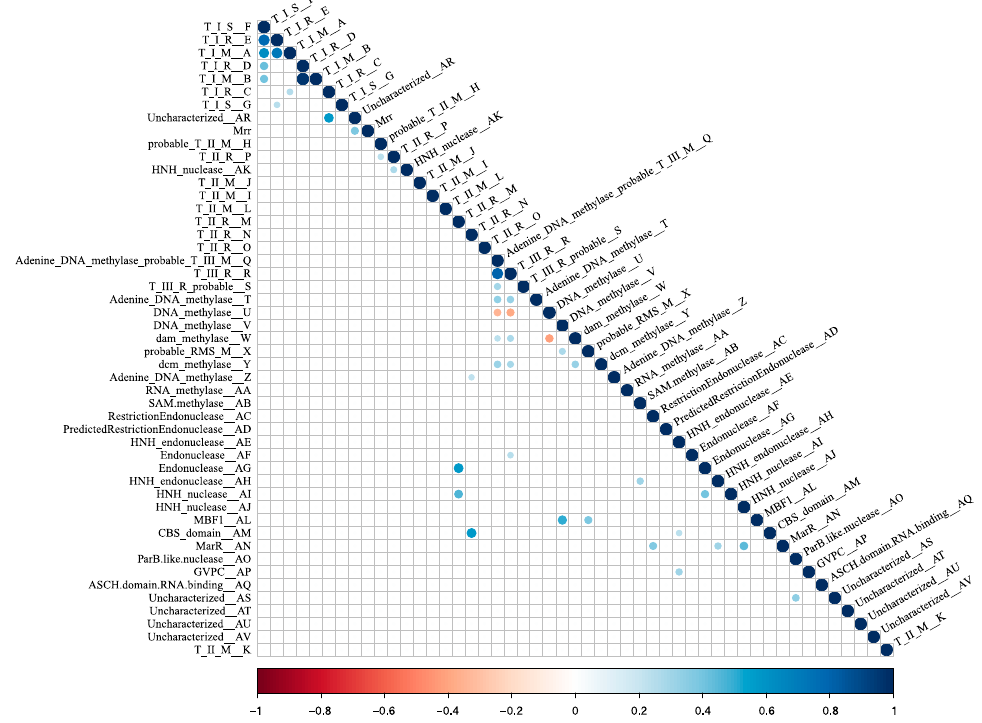
Figure 4. Heatmap of co-occurrence between the 48 RMS-candidate cHGs. Positive correlation indicates the cHGs co-occur while negative indicates that the presence of one means the other will not be present. Significance level is p < 0.05 with a Bonferroni correction applied for multiple tests. Blue indicates significant positive correlation; red indicates a significant negative correlation.